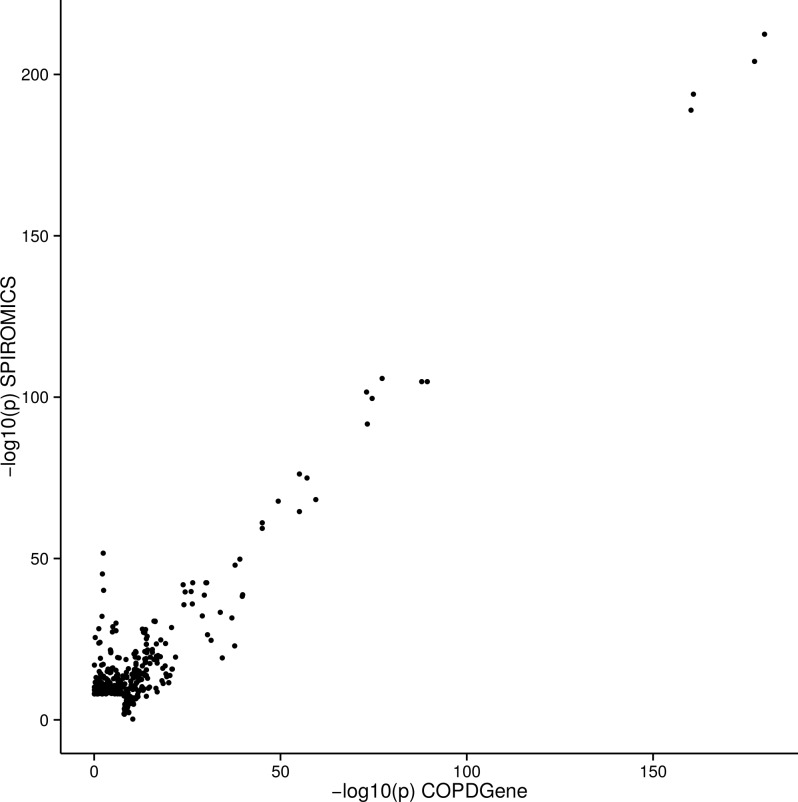
Comparison of–log10 p values for pQTL SNPs in SPIROMICS and COPDGene cohorts.The–log10(P value) of each pQTL SNP is plotted on the x-axis for COPDGene and the y-axis for SPIROMICS. 164 of 182 significant pQTLs in COPDGene were replicated in SPIROMICS at a P < (0.05/182 to correct for multiple tests). 209 of 290 significant pQTLs in SPIROMICS were replicated in COPDGene at a P < (0.05/290 to correct for multiple tests). See also S3 Table.